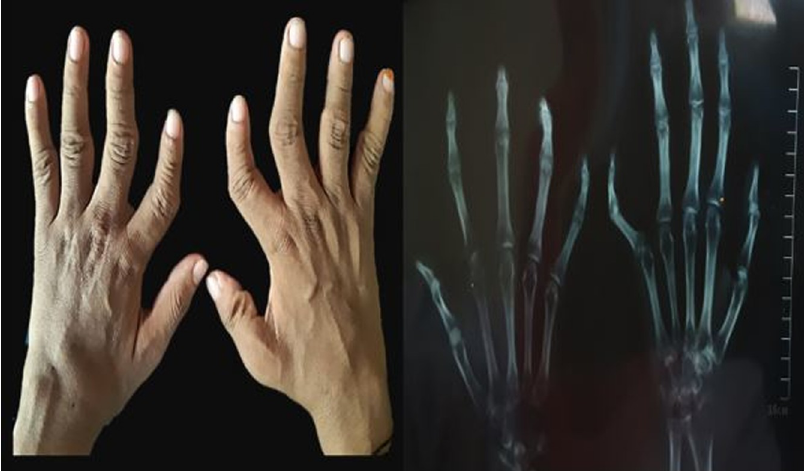
Fig 1. Physical feature of hand. Physical appearance of patient’s hands depicted that patient suffers from severe joint pain.